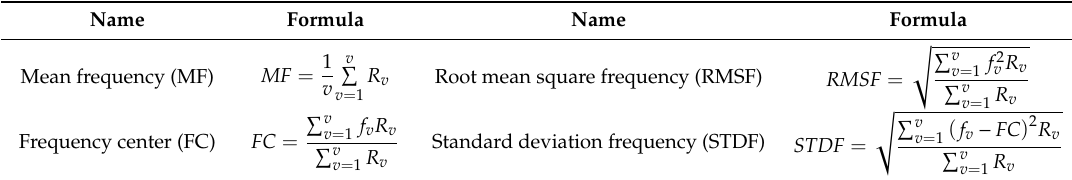
Table A2. Frequency domain features